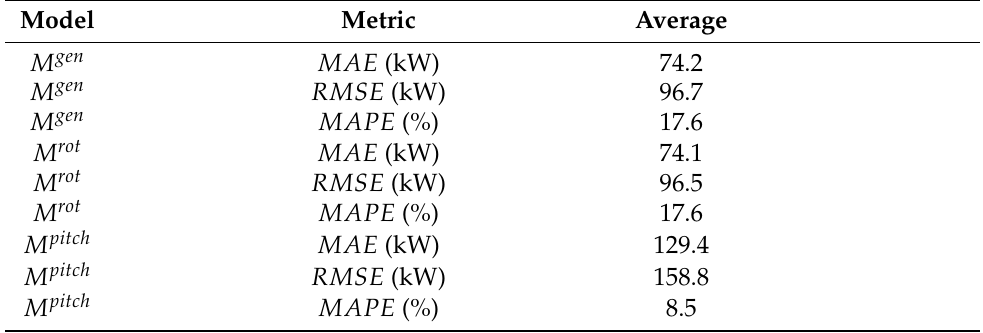
Table 12. Results of the multivariate Principal Component Regression (PCR) models validation (WF2): for brevity, the average wind farm results are